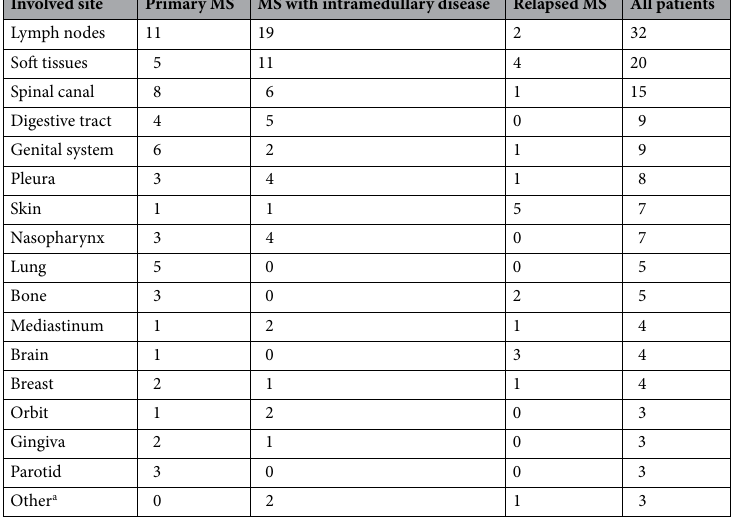
Table 2. The involved sites of MS in 118 patients. MS myeloid sarcoma. a Optic nerve, bladder, spleen.